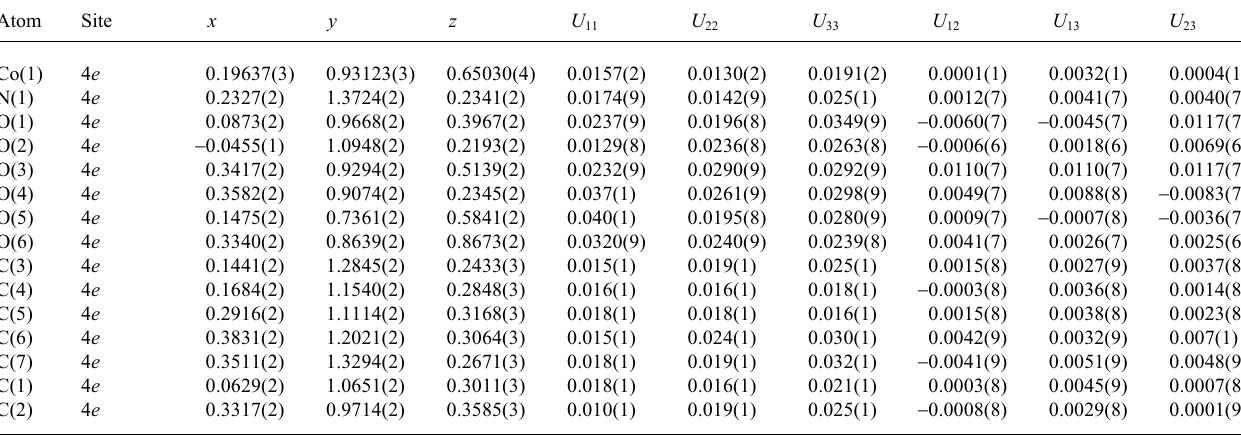
Table 3. Atomic coordinates and displacement parameters (in Å 2